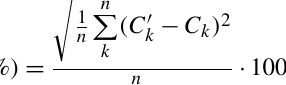
Figure 3. Comparison between simulation results and experimental data (Meroney et al., 1996). (a) Comparison between modeled con- centration and experimental measurements at each location. (b) Lin- ear fit between experimental measurements and modeled concentra- tions.